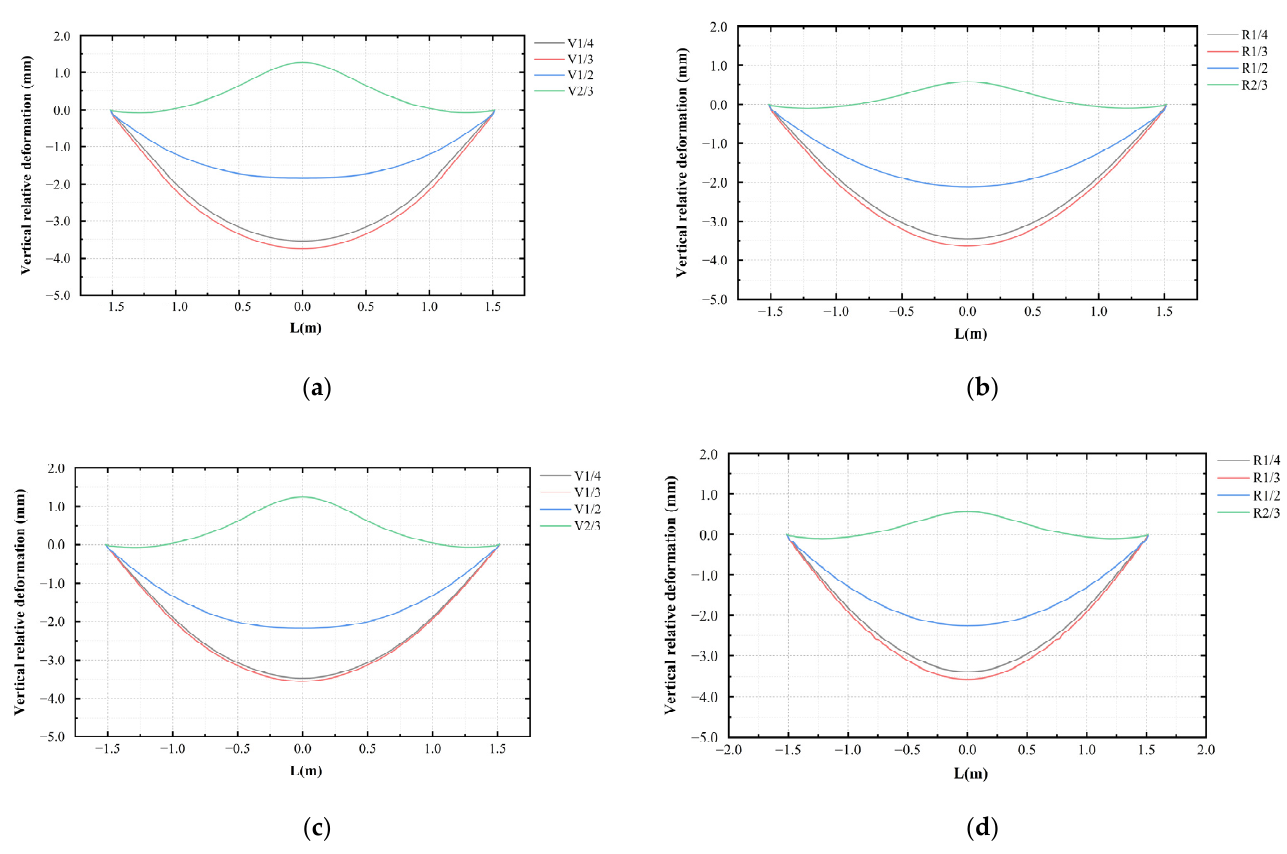
Figure 16. Vertical deformation: ( a ) unstrengthened specimens (CDP); ( b ) strengthened specimens (CDP); ( c ) unstrengthened specimens (XFEM); and ( d ) strengthened specimens (XFEM).